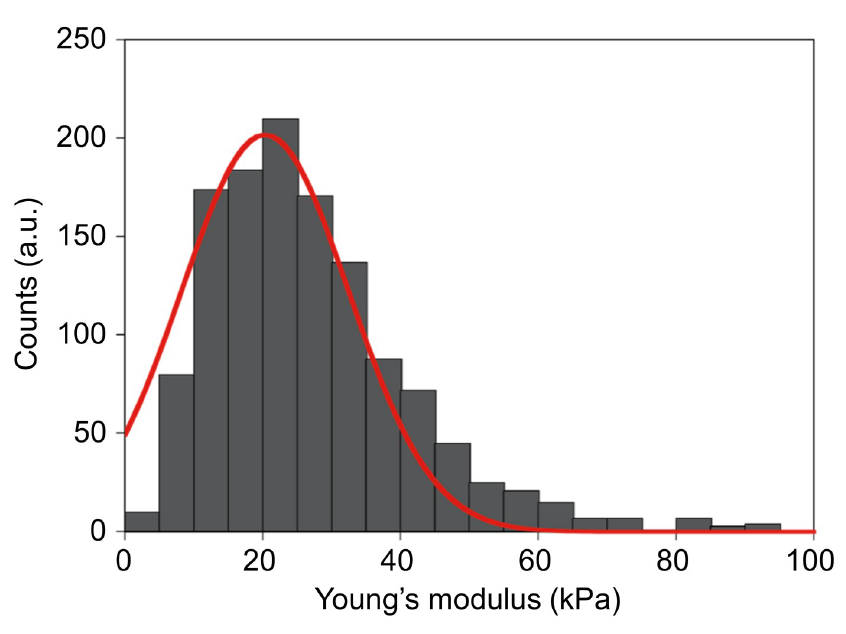
Fig 4. Young’s modulus of the swelled apoferritin hydrogel measured with AFM.